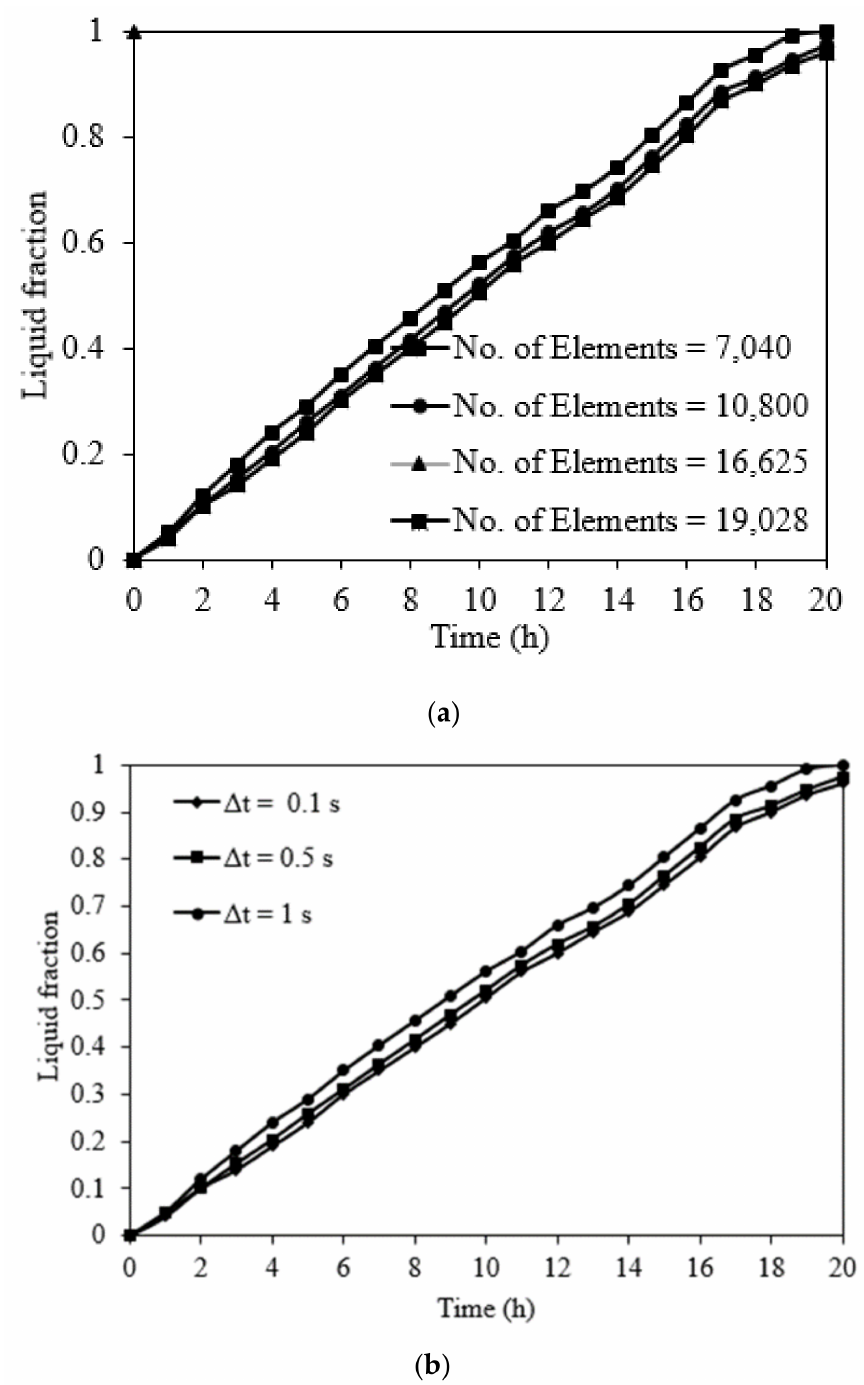
Figure 4. Accuracy of the model. ( a ) Grid independence test, and ( b ) time independence